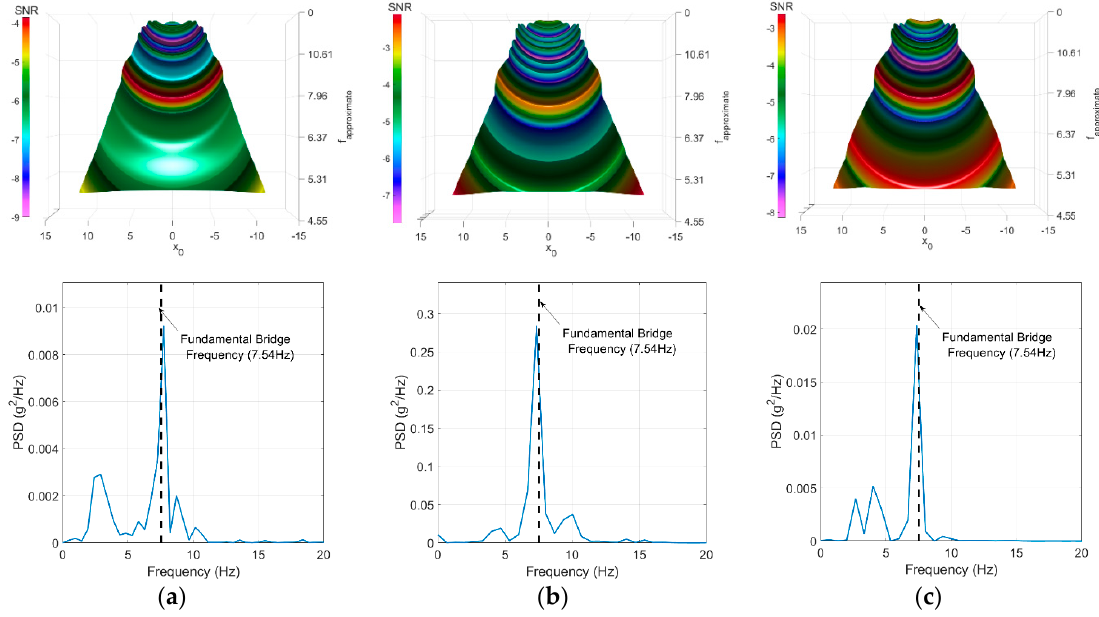
Figure 19. FI-UPSR SNR surface plots and signals PSD for the three tests. ( a ) Test 1, ( b ) Test 2, and ( c ) Test 3.